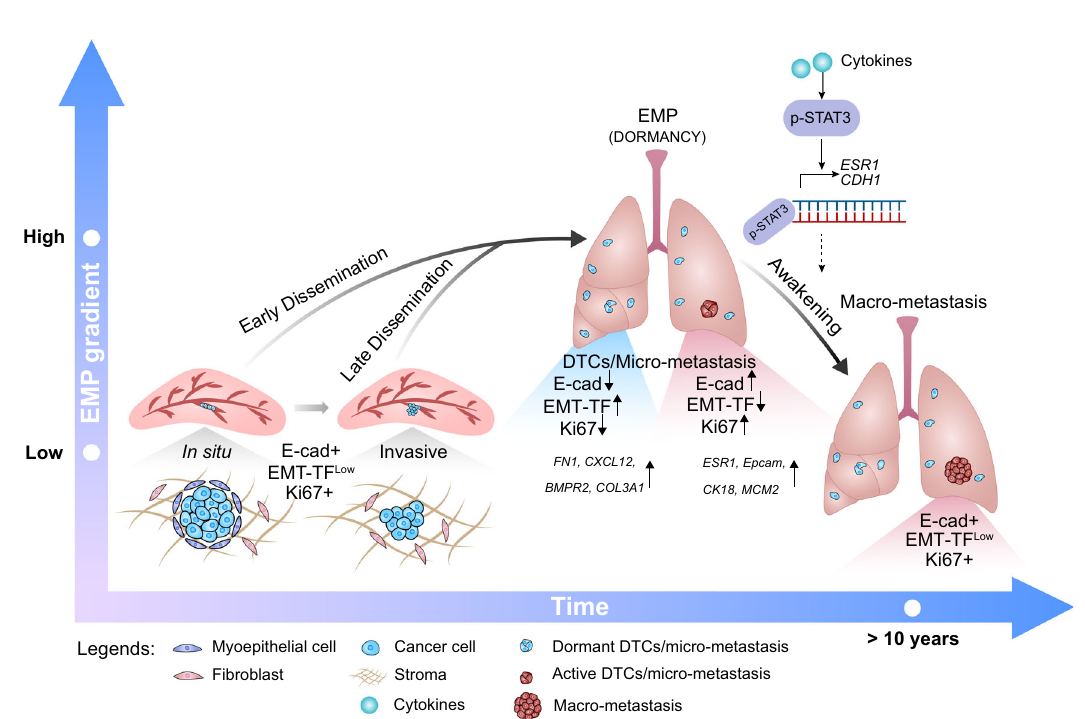
Fig. 8 | Working Model for ER + BC progression. ER + tumor cells progress from in situ to invasive stage in an epithelial state characterized by high expression of E-cadandlowexpressionofEMT-TFs.Atdistantsites,DTCsshowEMPfeaturesand enter dormancy. Awakening from dormancy involves restoration of E-cad expres- sion that may be triggered by cytokines resulting in STAT3 activation